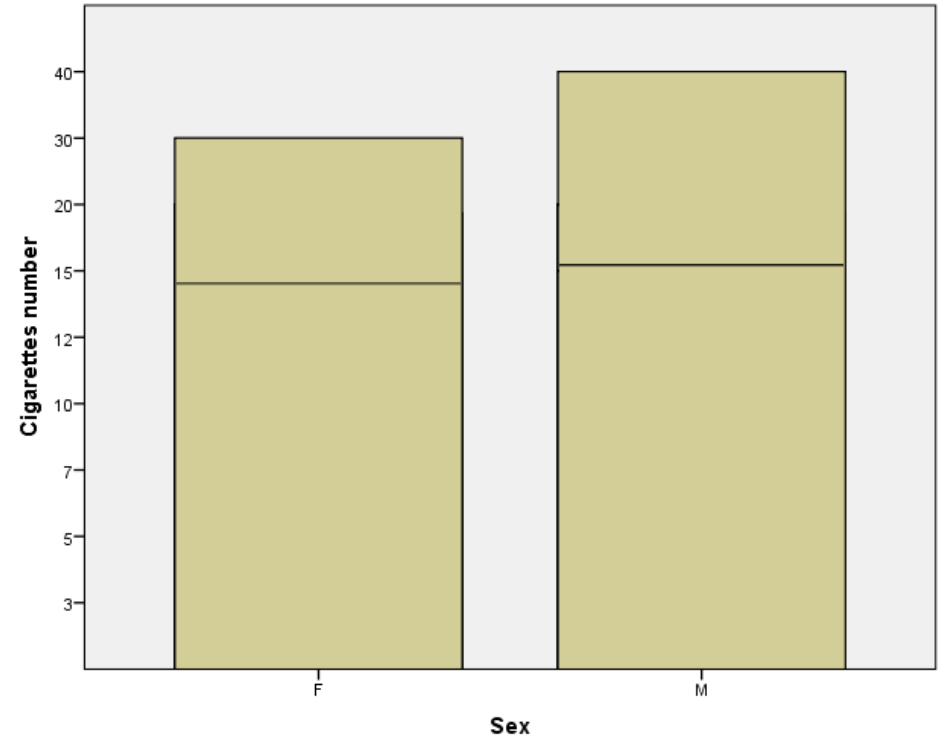
Figure 6. Number of cigarettes in females (F) and males (M)